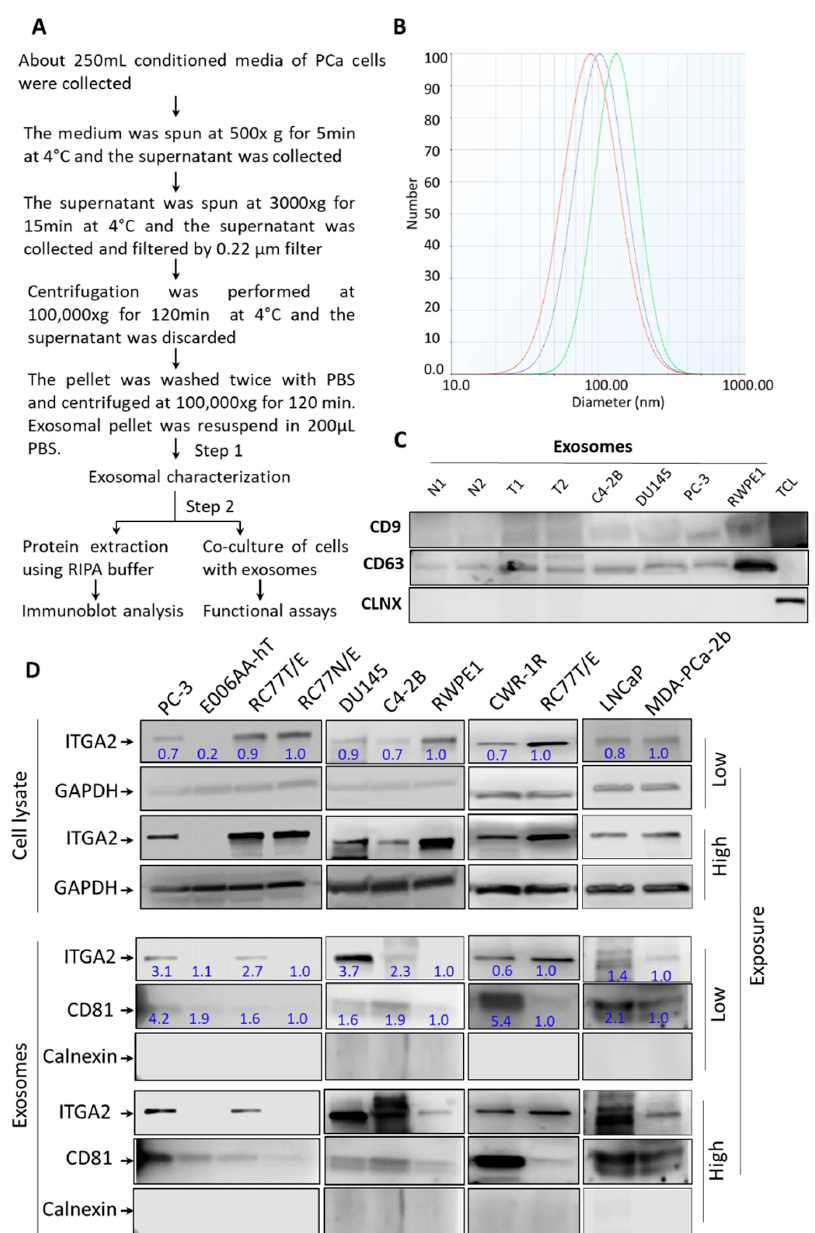
Figure 1. Isolation, characterization and expression of ITGA2 in exosomes derived from PCa cells. ( A ). Schematic representation of exosome isolation from PCa cells by differential ultracentrifugation. Conditioned media collected from PCa cells were used for exosomes extraction. ( B ). Zeta potential analysis was performed to determine the number, average size, and homogeneity of exosomes isolated form of PC-3 cells ( n = 3). ( C ). Exosomes were characterized by immunoblotting (IB) analysis. About 10 µg of exosomes derived from conditioned media of cells or plasma of PCa patients (T) and normal subjects (N) in addition to total cell lysate (TCL) of LNCaP cells were loaded onto 12.5% SDS-PAGE gel. IB analysis shows the expression of calnexin as a cellular marker and CD9 and CD63 as exosomal markers. ( D ). Enrichment of exosomal content of ITGA2 was evaluated in exosomes compared to cell lysates collected from LNCaP, C4-2B, DU145, PC-3, CWR-R1ca, RC77T/E, RC77N/E, RWPE-1, MDA-PCa-2b, and E006AA-hT cells using Western blot analysis. Twenty micrograms of protein lysates were loaded, and the membranes were incubated with anti-ITGA2, anti-GAPDH, anti- CD81, and anti-calnexin (CLNX) antibodies. These experiments were repeated at least three times.